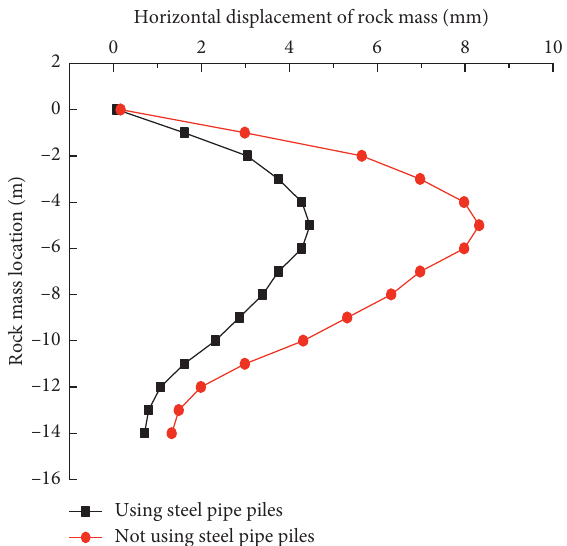
Figure 20: The horizontal displacement of rock mass with and without steel pipe piles.